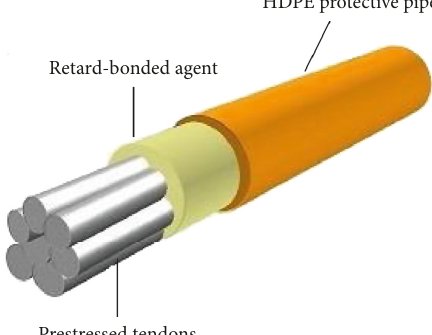
Figure 1: Retard-bonded prestressed steel tendons (RBPT).